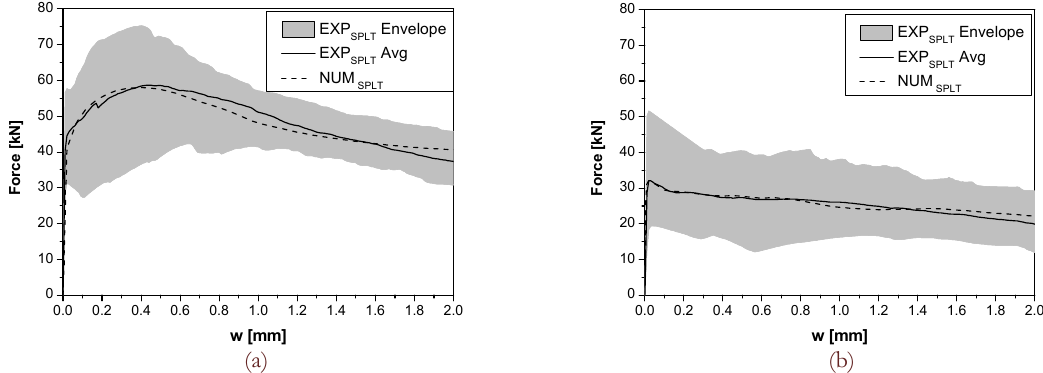
Figure 12: Experimental and numerical force – crack width relationship, F-w , for: (a) θ = 0 ° and (b) θ = 90 ° .